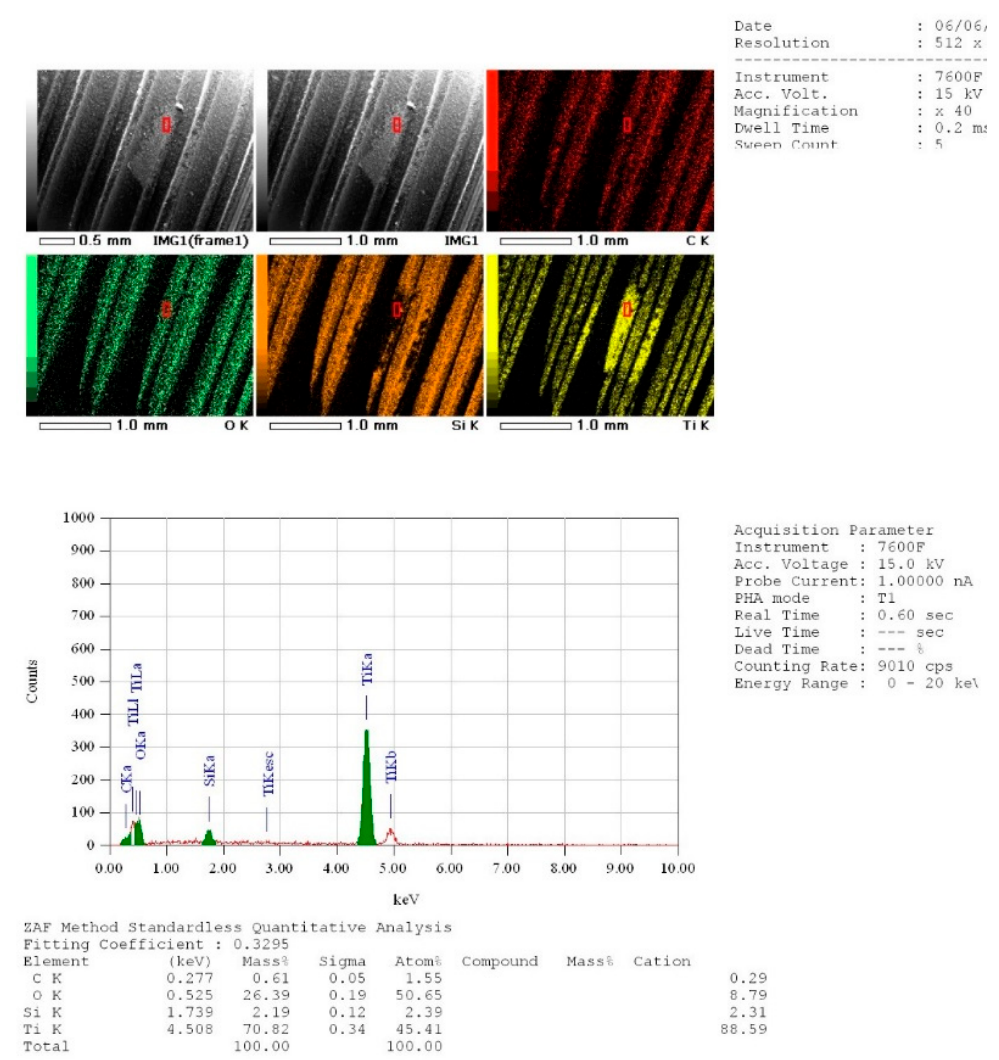
Figure 8. An example of an Energy Dispersive X-ray (EDX) measurement showing the value of Carbone (mass percentage) on lased surface of the group C + L.